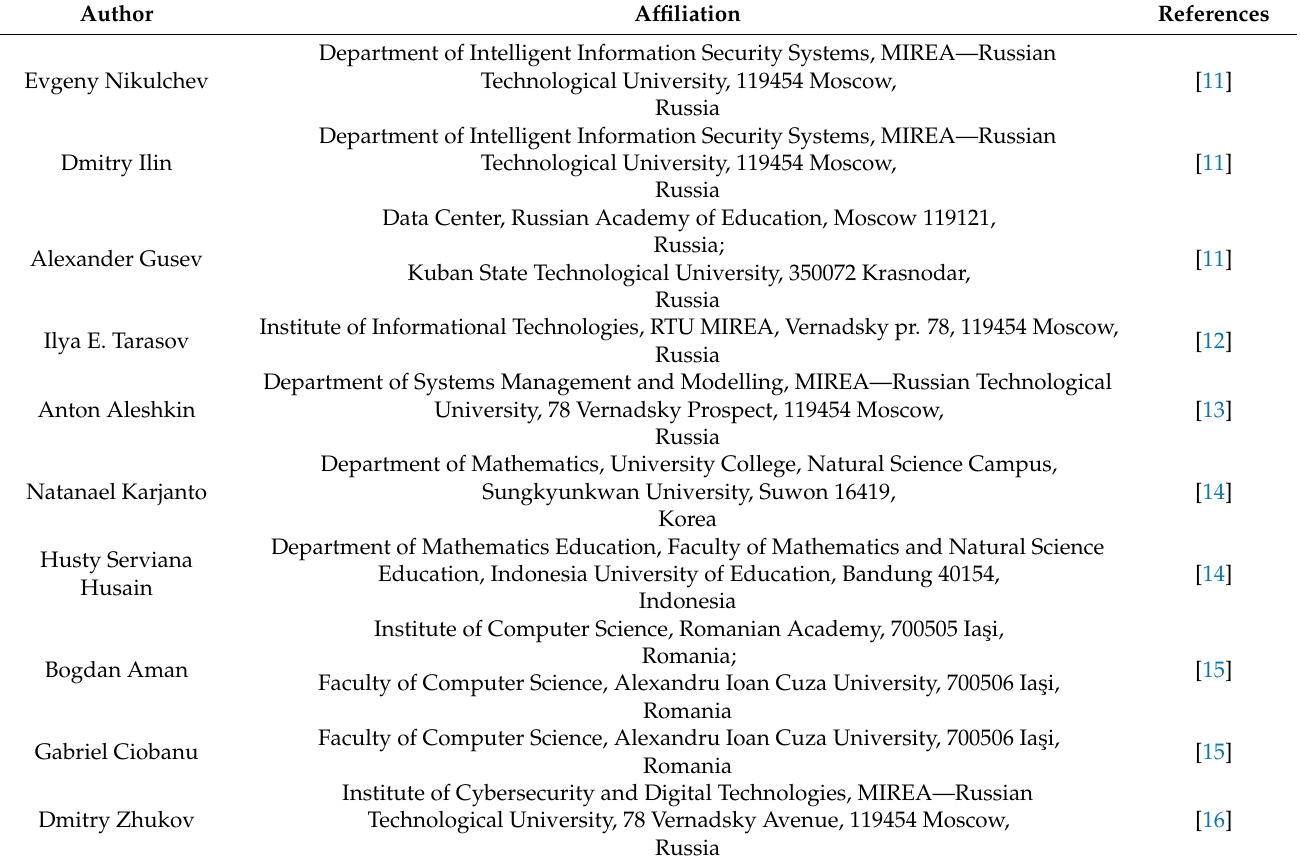
The authors of this Special Issue and their affiliations are shown in Table 1. Table 1. Affiliations and bibliometric indicators for Table 1. A ffi liations and bibliometric indicators for authors.